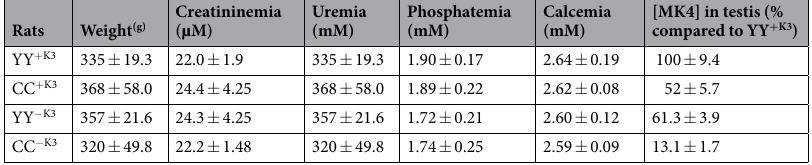
Table 1. Weight and biochemical parameters of homozygous YY, CC and heterozygous YC rats aged of 16 weeks after a vitamin K 3 deficient diet ( − K3) or standard diet ( + K3) feeding for 12 weeks. Results expressed as mean ± SD. n = 6 for groups for YY + k3 and YY − K3 groups and n = 11 and 10 for groups CC + K3 and CC − K3